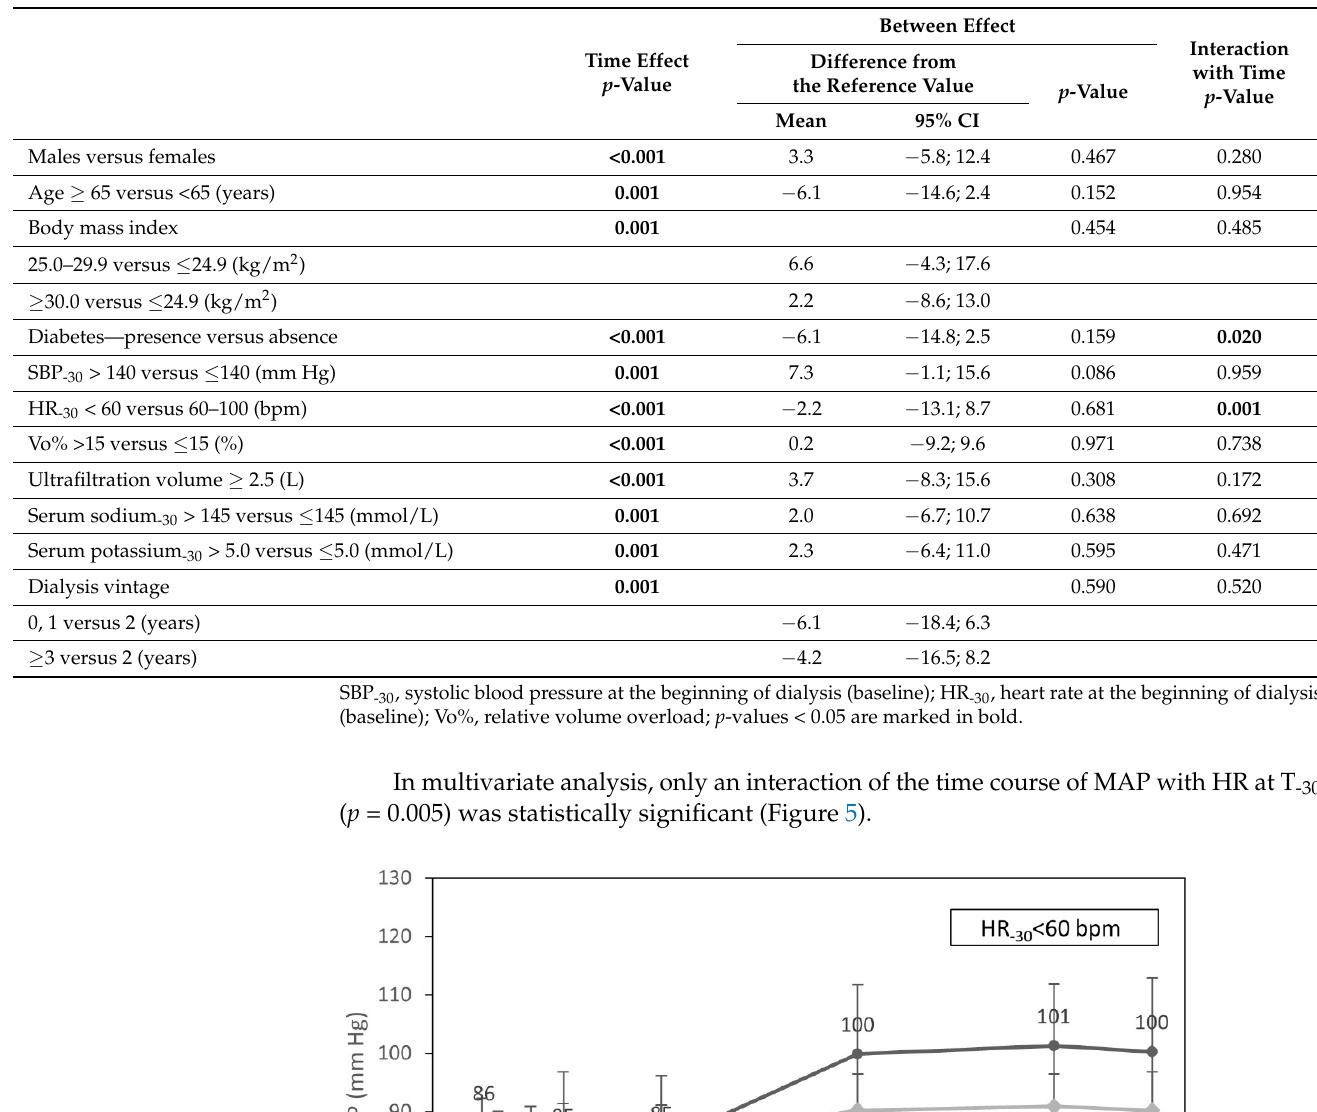
Table 7. Dynamics of mean arterial pressure during hemodialysis in relation to selected clinical and dialysis parameters.